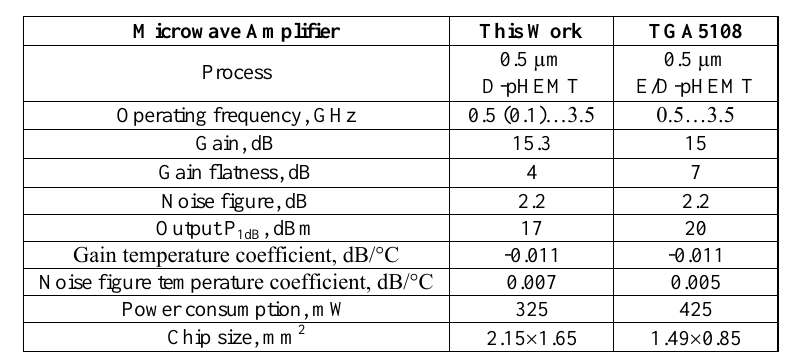
Fig. 6. Measured gain and noise figure versus frequency (а) and gain and output power versus input power (b) for the proposed amplifier in the ambient temperature range from -60 °C to +125 °C. Table 2. Measured performance summary of the proposed amplifier and its counterpart (Т = 25 °С).